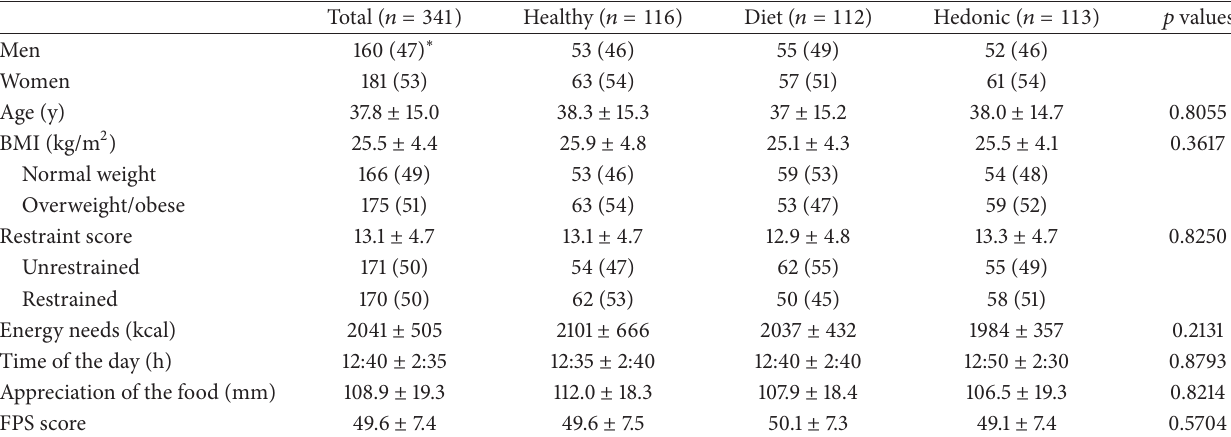
Table 2: Characteristics of participants for the total sample and each experimental condition.